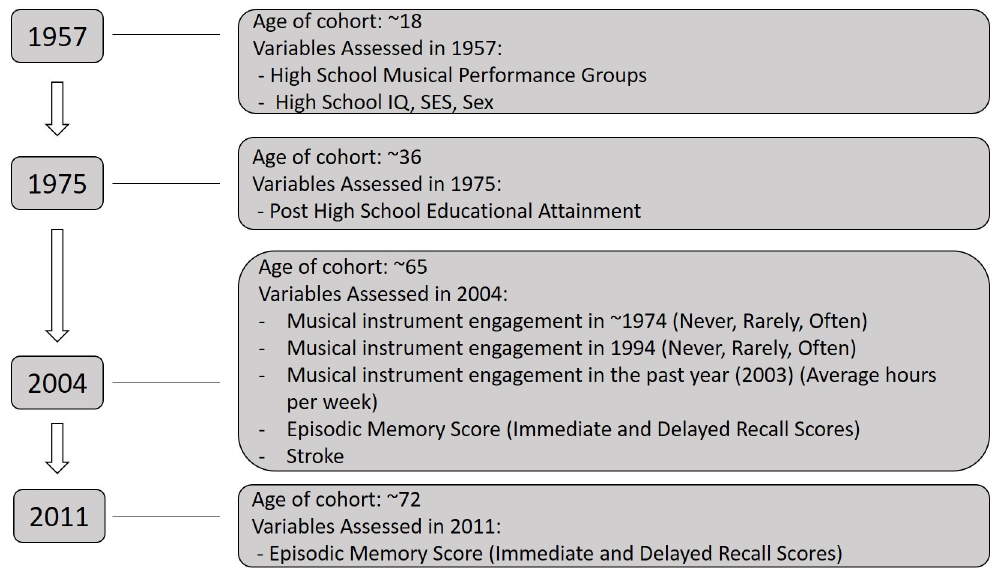
Fig 1. Flow diagram of variable assessments. Data were collected at multiple timepoints from 1957 when participants were approximately 18 years of age, through 2011 when participants were approximately 72 years of age.